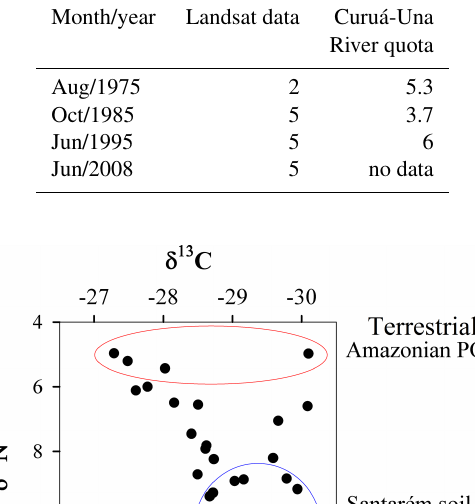
Table 1. Satellite acquisition data from the United States Geological Survey (USGS) and the Curuá-Una River quota from the Brazilian Water Agency (ANA).